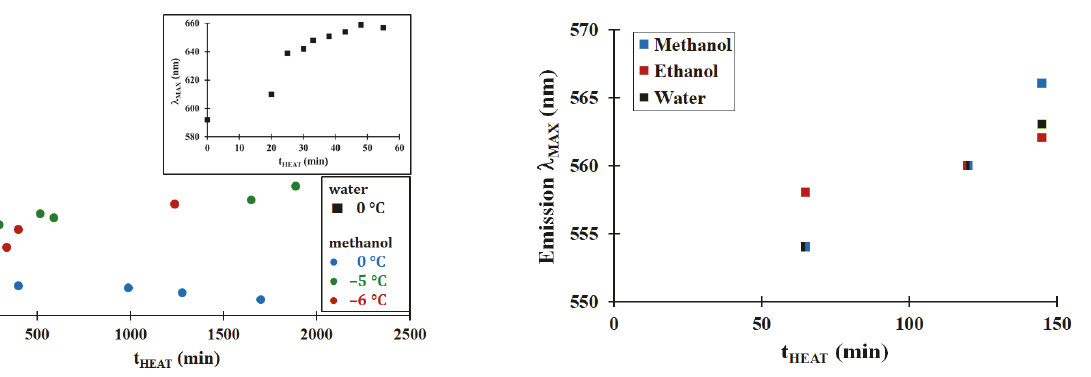
Figure 3: Effect of heating time on the fluorescence emission prop- erties of mercaptosuccinic acid-modified CdSe QDs synthesized at various temperatures. Inset is the expanded water data for clarity.